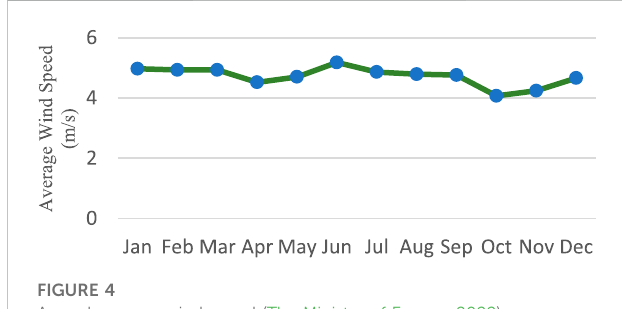
FIGURE 4 Annual average wind speed (The Ministry of Energy, 2022).